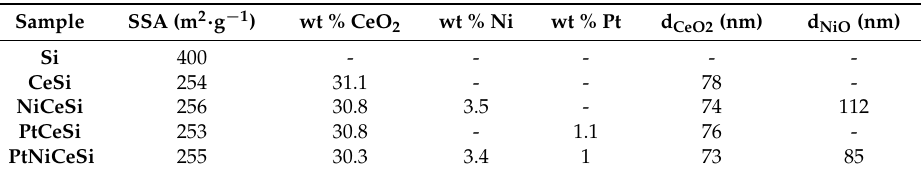
Table 1. Chemical composition and structural properties of the as-prepared samples. Sample